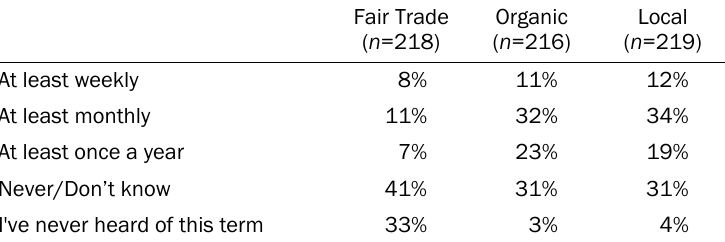
Table 2. Frequency of Student Purchases of Fair Trade, Local or Organic Foods